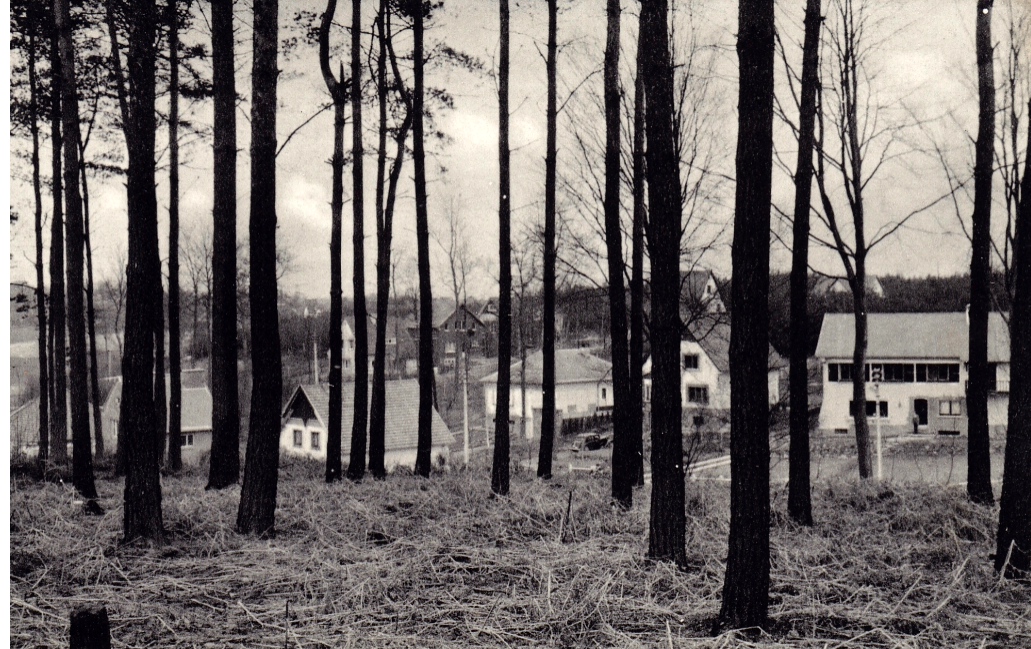
Figure 8. Wooded land built on through an allotment process. Avenue Joséphine-Charlotte, picture from the J.-L. Lebrun collection. Source: de Séjournet, E.